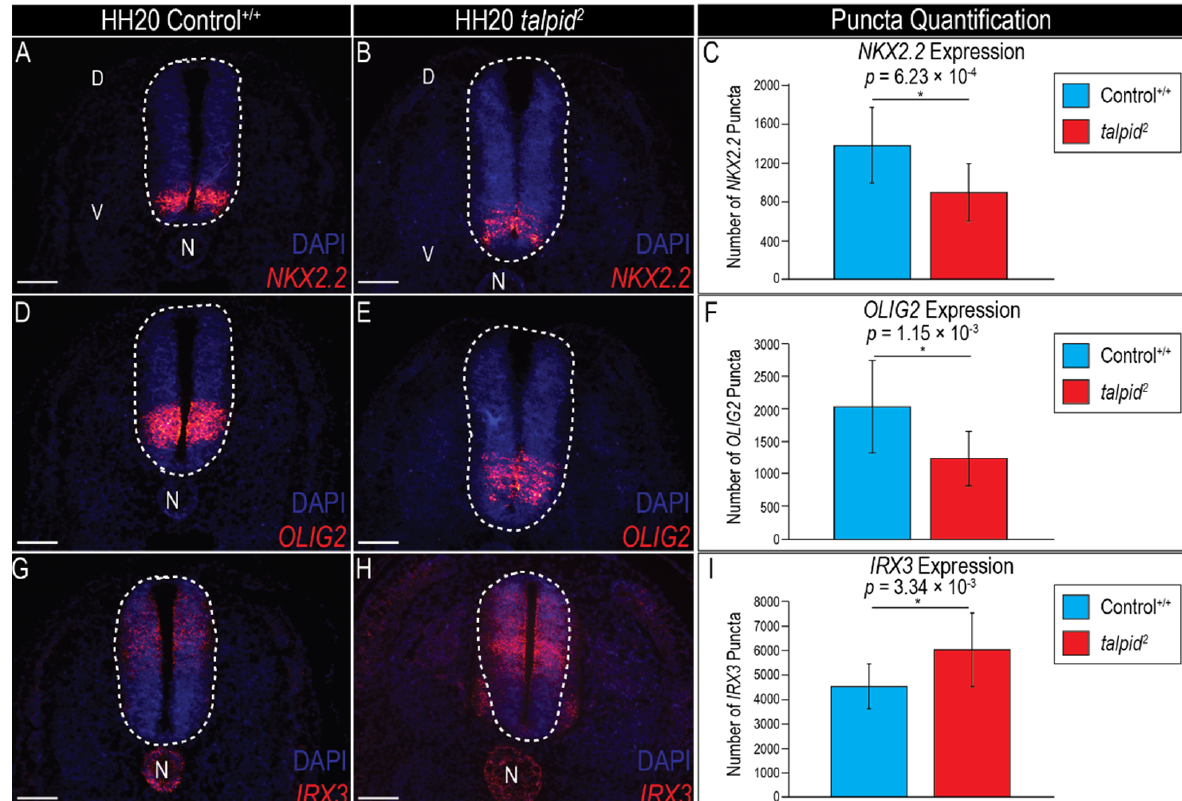
Figure 2. Expression of markers for ventral neuronal progenitors is reduced in the ta 2 neural tube. ( A , B ) RNAscope in situ hybridization for NKX2.2 in HH20 control +/+ and ta 2 neural tubes. ( C ) Puncta quantification for NKX2.2 expression in HH20 control +/+ and ta 2 neural tubes. ( D , E ) RNAscope in situ hybridization for OLIG2 in HH20 control +/+ and ta 2 neural tubes. ( F ) Puncta quantification for OLIG2 expression in HH20 control +/+ and ta 2 neural tubes. ( G , H ) RNAscope in situ hybridization for IRX3 in HH20 control +/+ and ta 2 neural tubes. ( I ) Puncta quantification for IRX3 expression in HH20 control +/+ and ta 2 neural tubes. D: dorsal, N: notochord, V: ventral. White dotted ovals outline the neural tubes. Scale bars: ( A , B ; D , E ; G , H ) 100 µ m. Error bars represent the mean data ± s.d. Statistical analysis was performed utilizing Student’s t -test (* denotes p < 0.05).